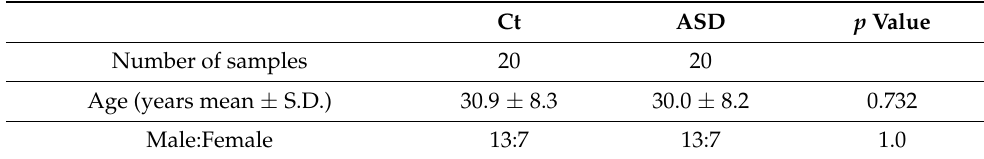
Table 1. Demographic and clinical data of discovery cohort. Ct ASD p Value Number of samples 6 6 Age (years mean ± S.D.) 30.2 ± 8.5 31.7 ± 8.5 1.0 Male:Female 5:1 5:1 1.0 Values denote mean ± standard deviation; Ct: Control, ASD: Autism Spectrum Disorder. Table 2. Demographic and clinical data of replication cohort. Ct ASD p Value Number of samples 20 20 Age (years mean ± S.D.) 30.9 ± 8.3 30.0 ± 8.2 0.732 Male:Female 13:7 13:7